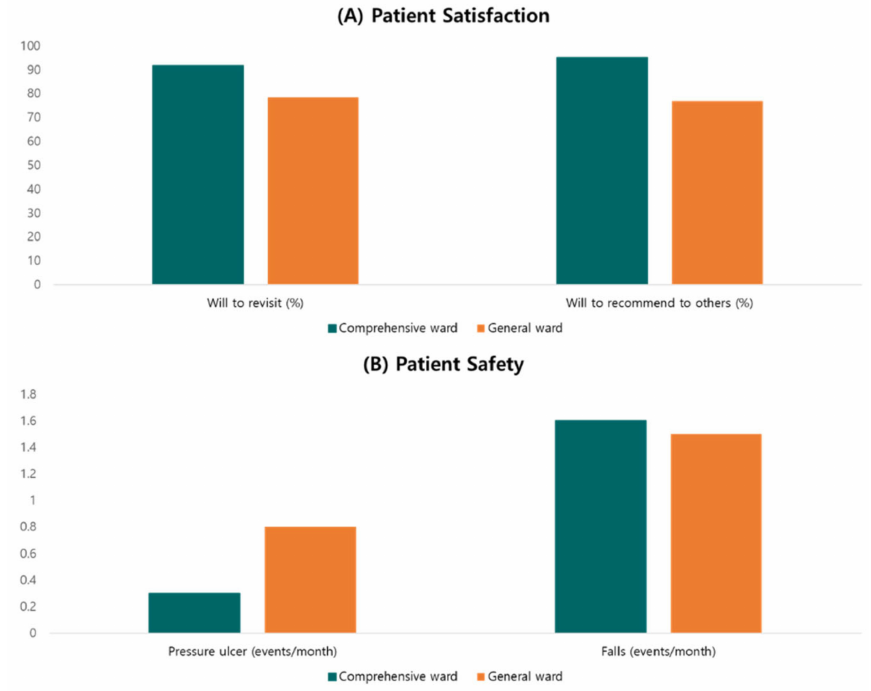
Figure 3. ( A ) Patient satisfaction (willing to re-visit and recommend to others, %); ( B ) patient safety (pressure ulcers and falls, events/month).